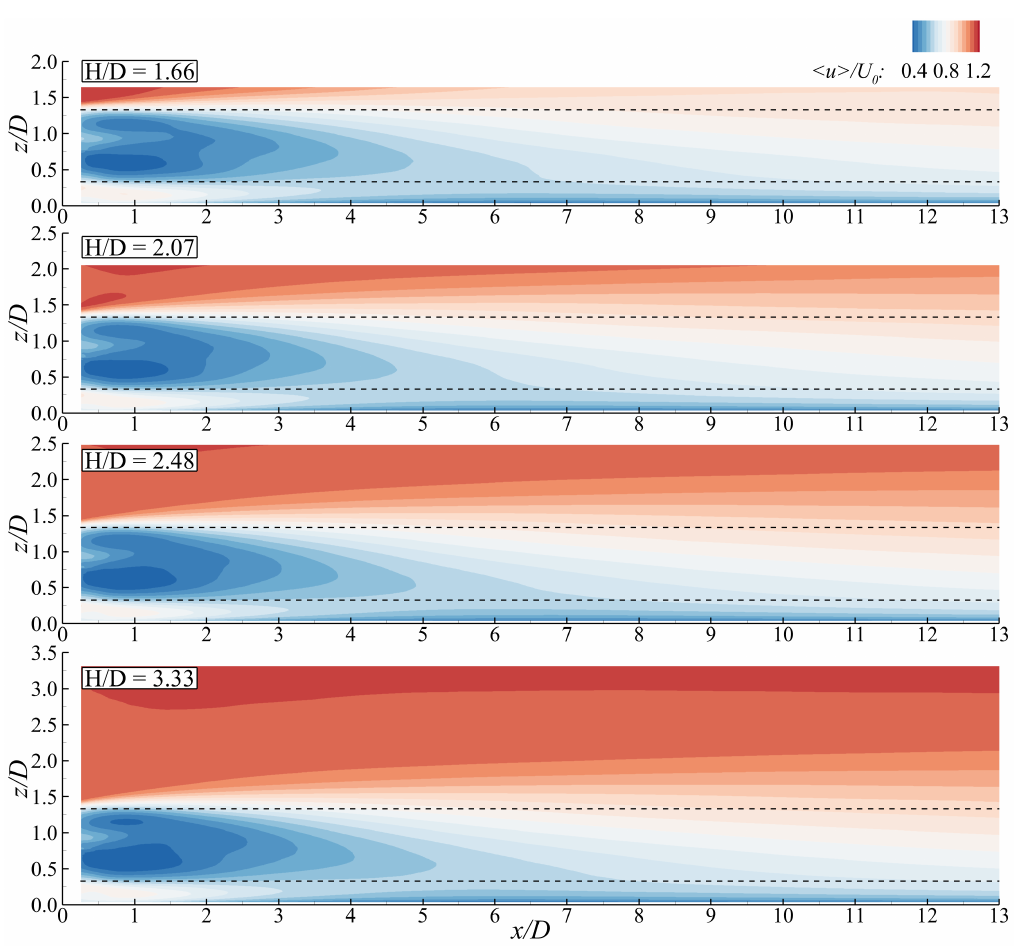
Fig. 2. Distribution of mean velocities over vertical planes for the four submergence cases. Results are averaged over the lateral wake region indicated in Figure 1. Turbine rotor are located at x/D =